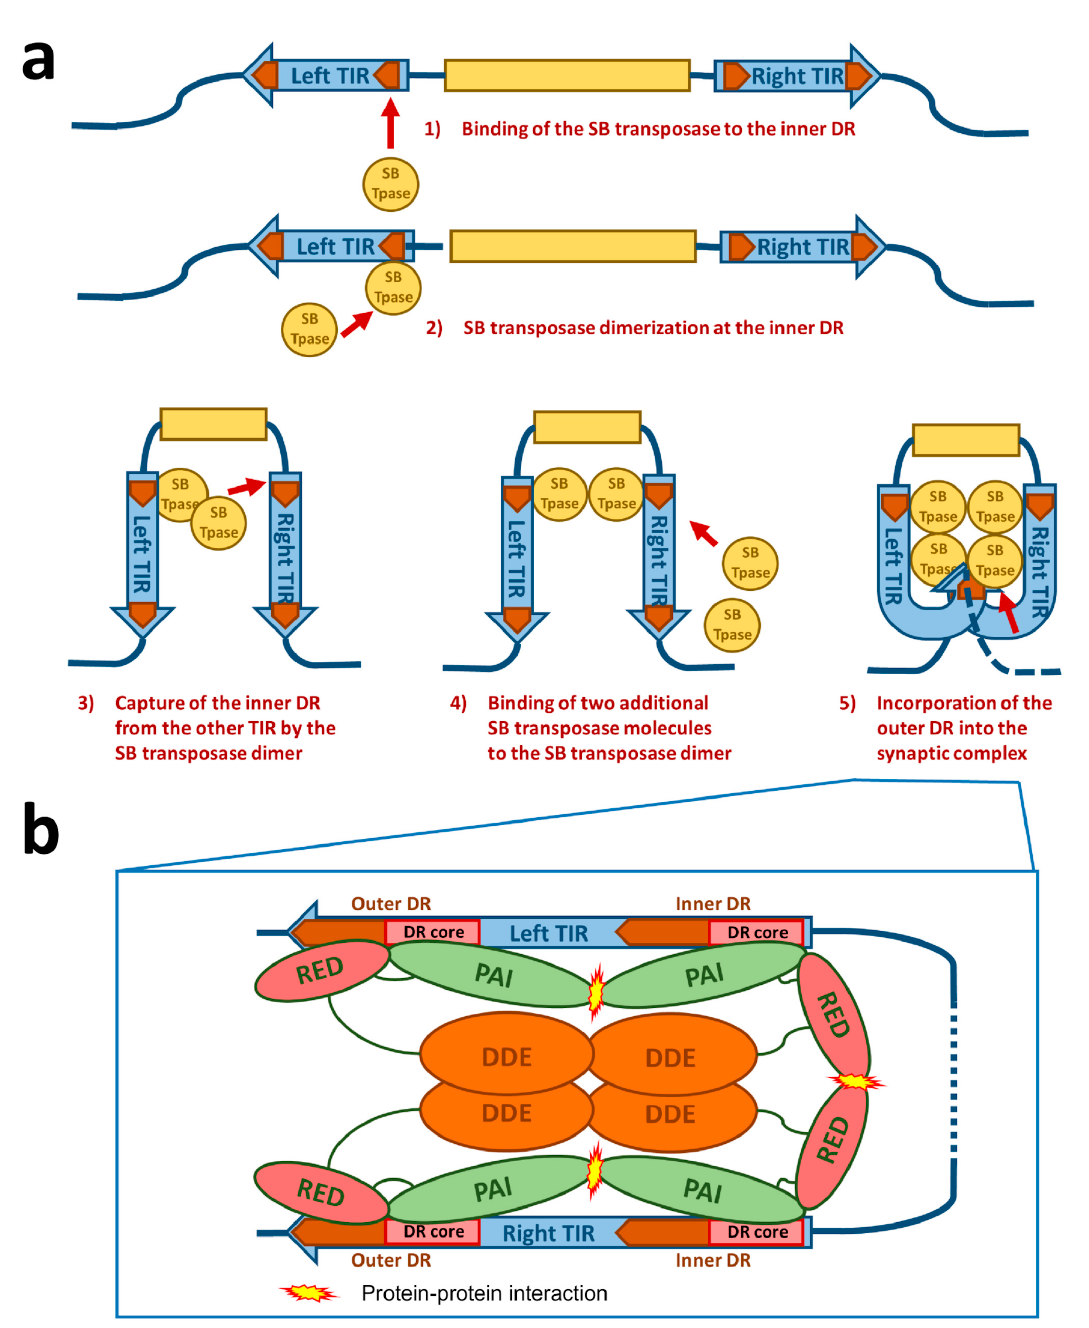
Figure 3. Schematic drawing of the synaptic complex formation. ( a ) At first, the SB transposase binds at the inner DR of the left TIR and forms dimers at this site. The SB dimer then captures the inner DR of the other TIR. Two additional SB transposase molecules are recruited to the nucleoprotein complex, leading to an incorporation of the outer DRs into the synaptic complex. ( b ) Protein–DNA and protein–protein interactions in the SB synaptic complex. The PAI subdomain of the N-terminal DNA-binding domain of the SB transposase interacts with the DR core sequence at both the inner and outer DRs. The RED subdomain contributes to DNA binding only at the outer DRs. At the inner DRs, the RED subdomain contributes to transposase dimerization. The relative positions of the four transposase monomers within the complex are arbitrarily drawn. Based on the structure of the Mos1 synaptic complex [37], it is likely that the catalytic DDE domains are acting in trans —that is, the DDE domain of an SB monomer bound at the left TIR executes cleavage at the right TIR and vice versa. For the formation of the synaptic complex, it has been proposed that a defined order of protein–DNA and protein–protein interactions is important [36] (Figure 3a). In this process, the assembly is mainly orchestrated by the interplay of the IR/DR structure